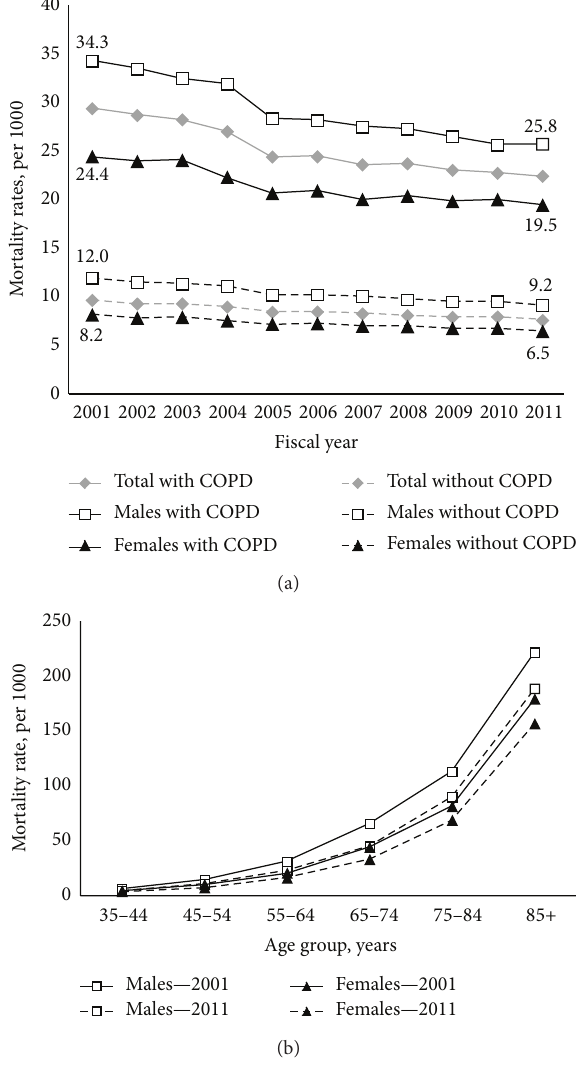
Figure 3: COPD all-cause mortality. (a) Age-standardized all- cause mortality rates among individuals aged 35 years and older with diagnosed COPD to those without diagnosed COPD, by sex, Quebec, 2001–2011. (b) Age-specific COPD all-cause mortality rates, by sex, Quebec, 2001 compared to 2011